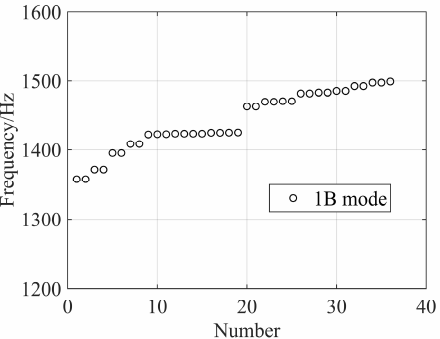
Figure 10. Modal frequencies of the first bending mode family.